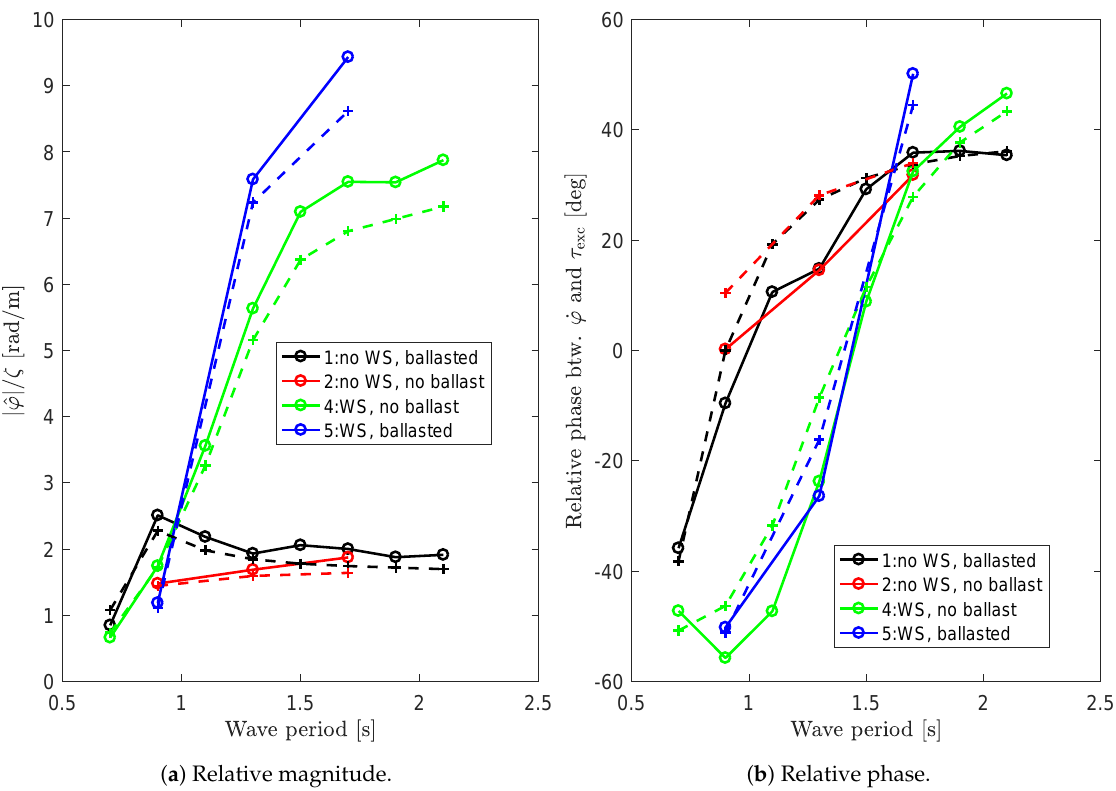
Figure 12. ( a ) Amplitude response and ( b ) relative angle between angular velocity and excitation torque. The phase is given as relative angle between angular velocity and excitation torque. Circle markers show the laboratory results, while crosses show the model results. Numbers 1, 2, 4, and 5 in the legend correspond to Setups 1, 2, 4, and 5,